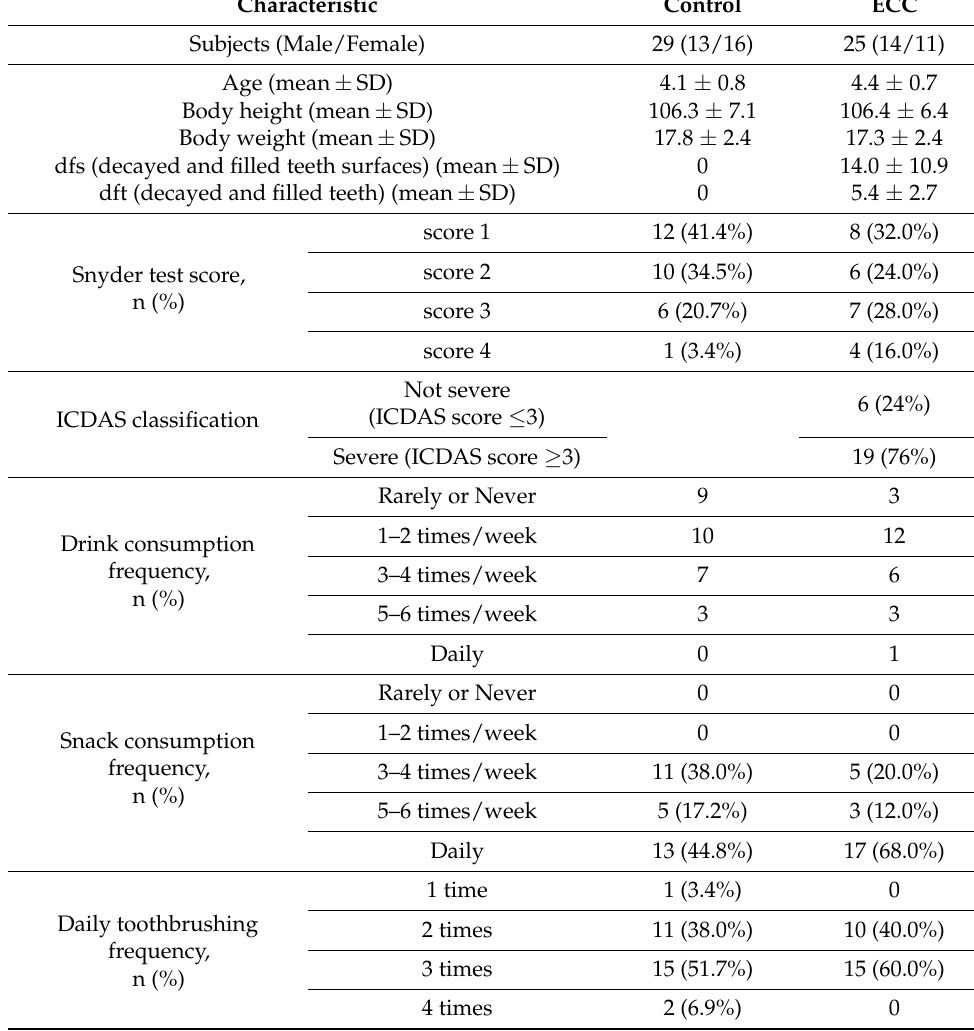
Table 1. Clinical information of the study participants.